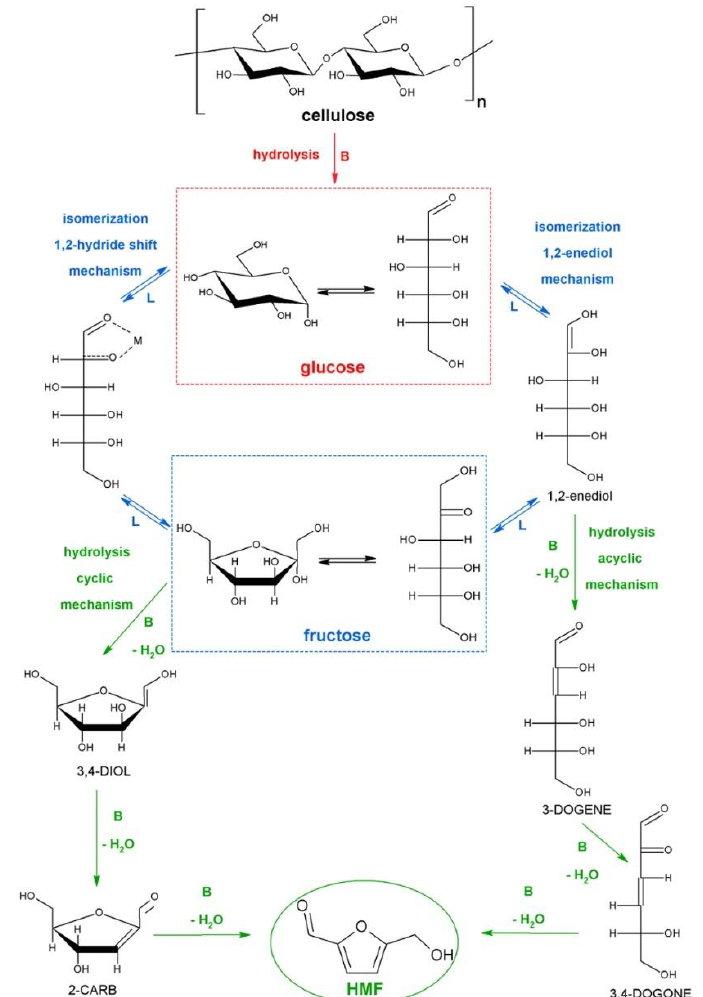
Figure 2. Mechanism of HMF synthesis from cellulose, carried out in the presence of both Brønsted (B) and Lewis (L) acids. “M” stands for “metal center”.